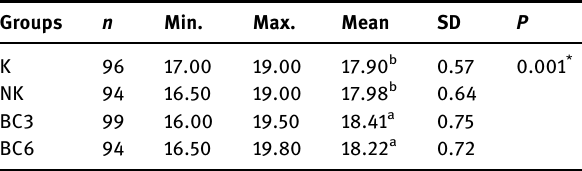
Table 4: Comparison of groups in terms of chick length Groups